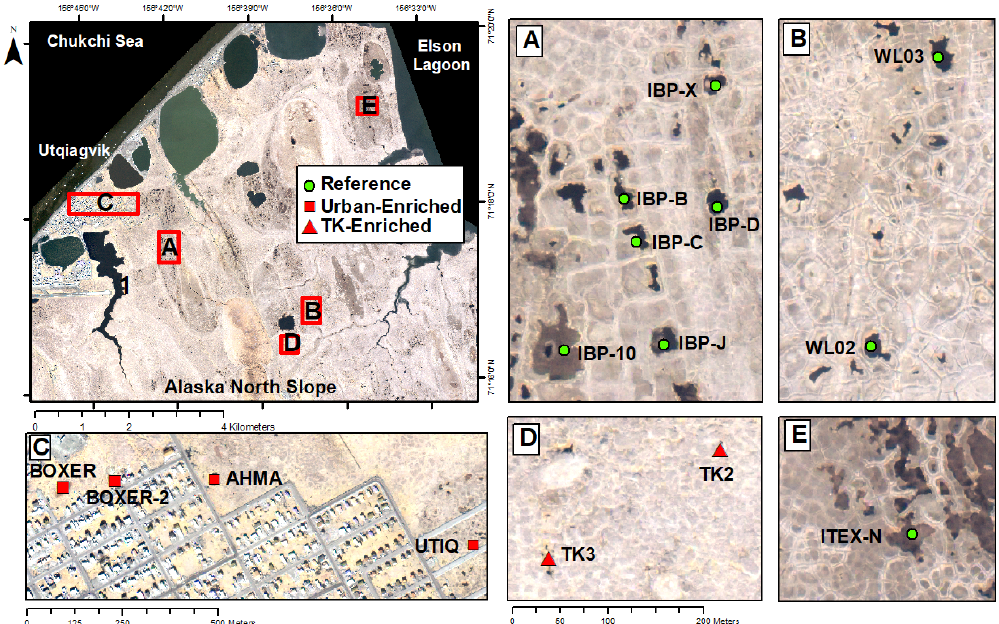
Figure 1. Map of Utqia˙gvik sites sampled in this study. For site details including southern sites, see Appendix Table A1 (Imagery© (2012) DigitalGlobe,